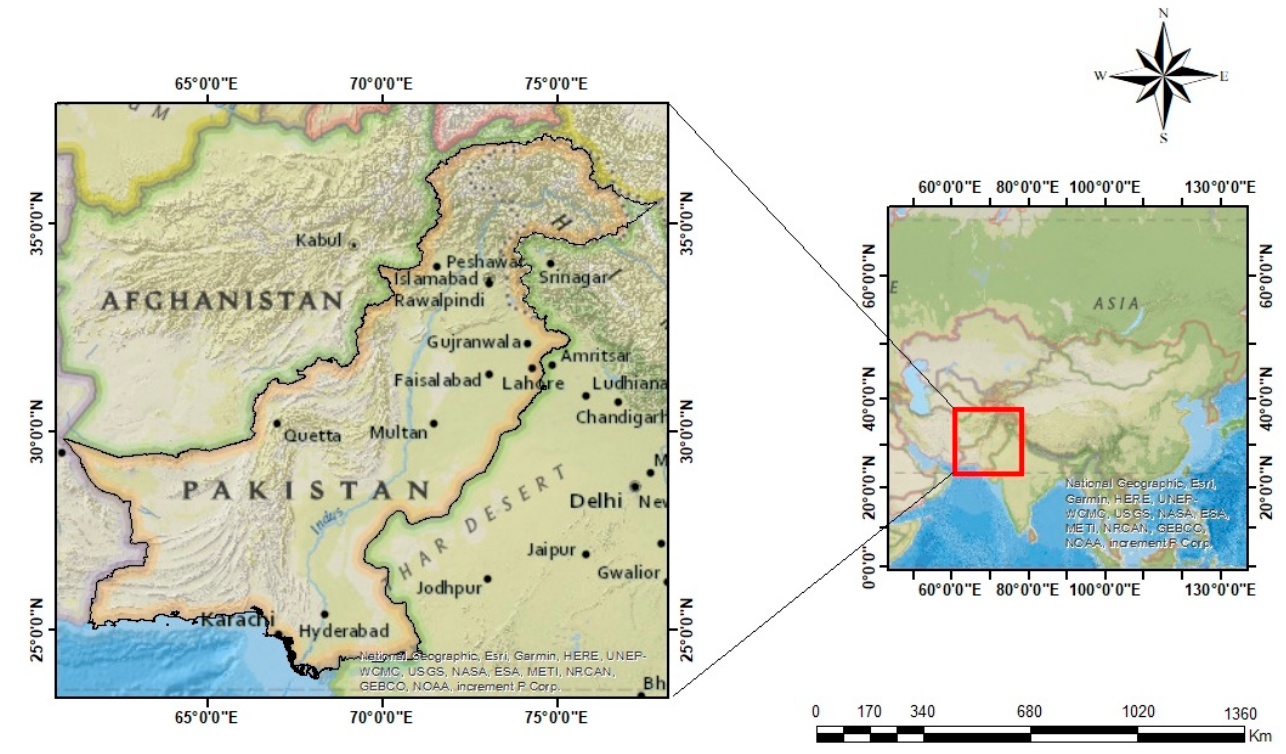
Figure 1. Location map of the study area (Pakistan).